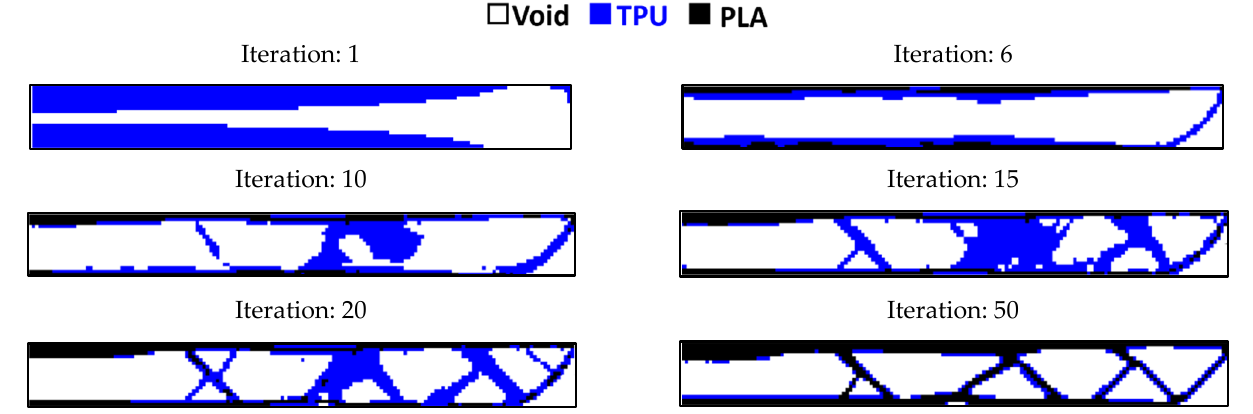
Figure 14. Optimizing the rectangular plane with multiple materials.